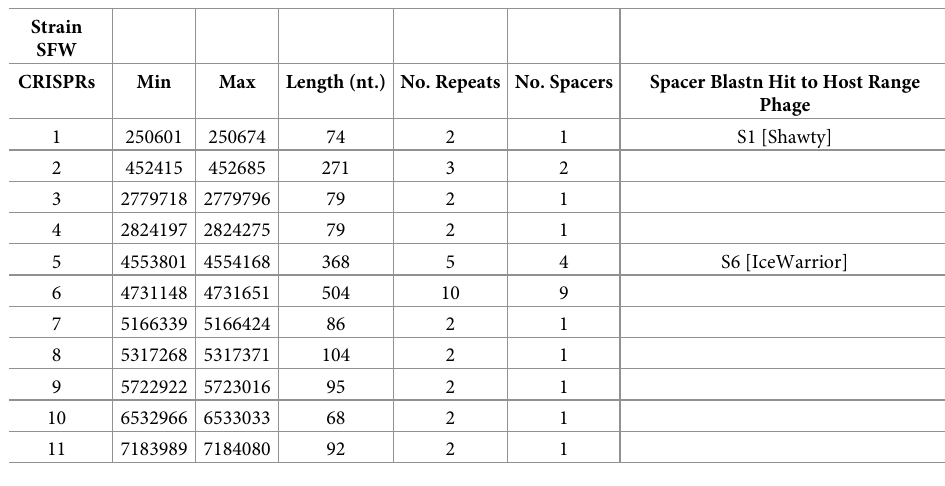
Table 13. Characteristics of the 11 CRISPRs predicted in the draft genome sequence of strain SFW.